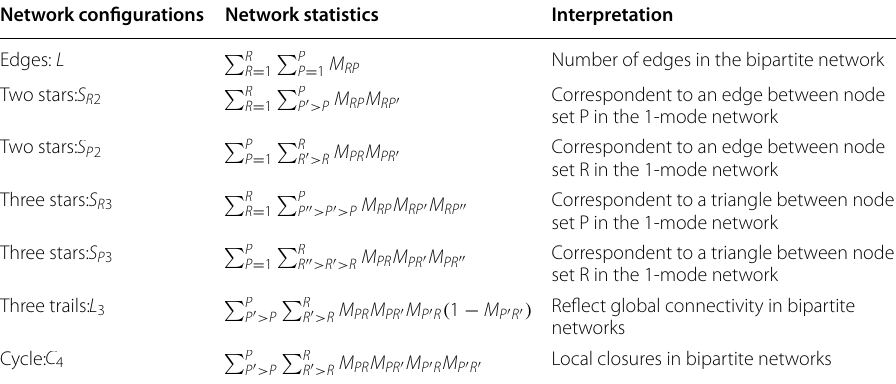
Table 4 Statistics of network configurations of bipartite networks Network configurations Network statistics